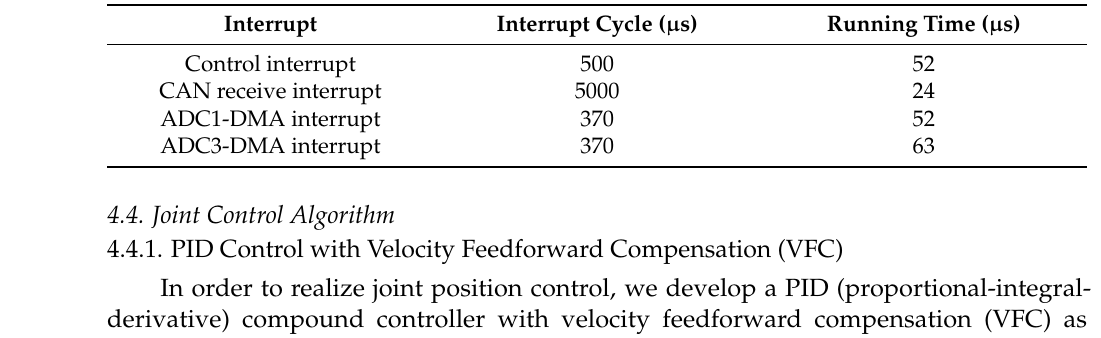
Table 2. Running time of ISR.